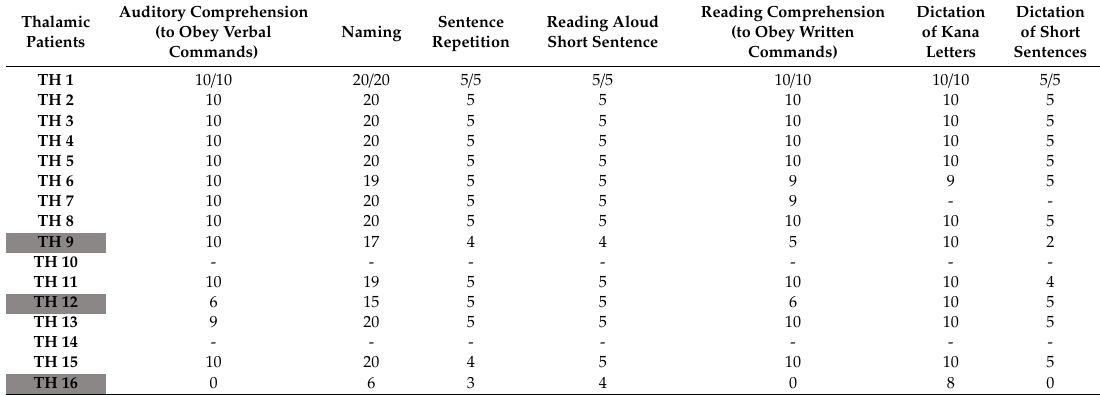
Table 2. Standard language test of aphasia (SLTA) results. Patients with dysphasia were highlighted. Thalamic